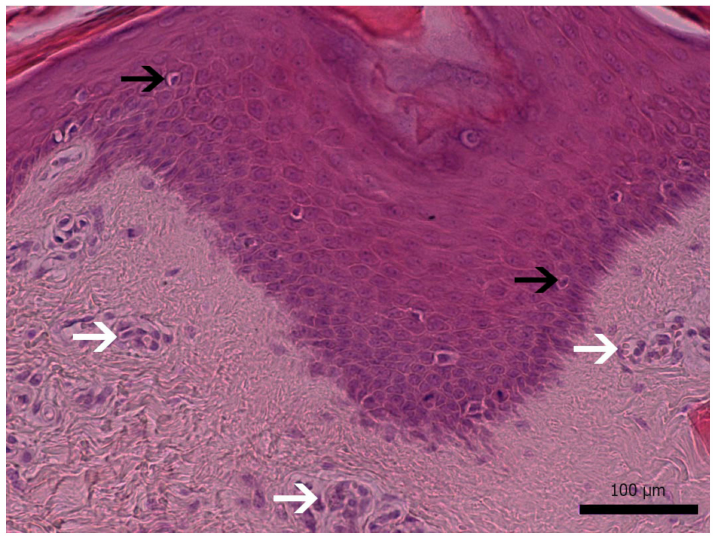
Figure 2. Histopathological findings: severe epidermal hyperplasia with scattered apoptotic bodies (black arrows). Prominent capillaries on superficial dermis (white arrows). H&E stain, magnification × 200 (bar: 100 µ